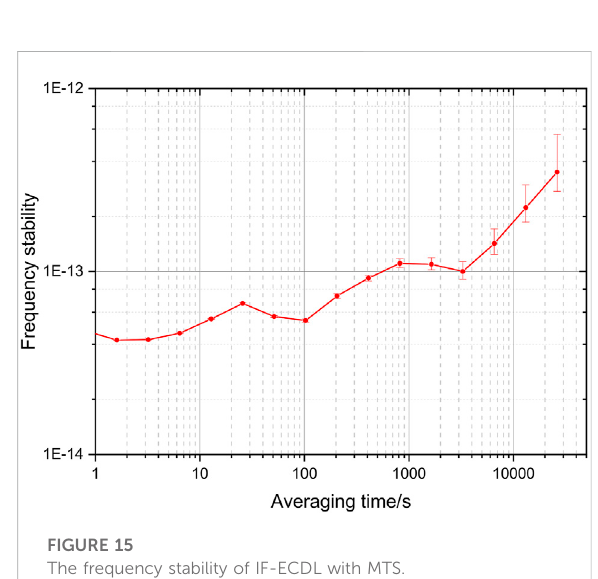
FIGURE 14 The scanned MTS signal of 87 Rb D2 line.